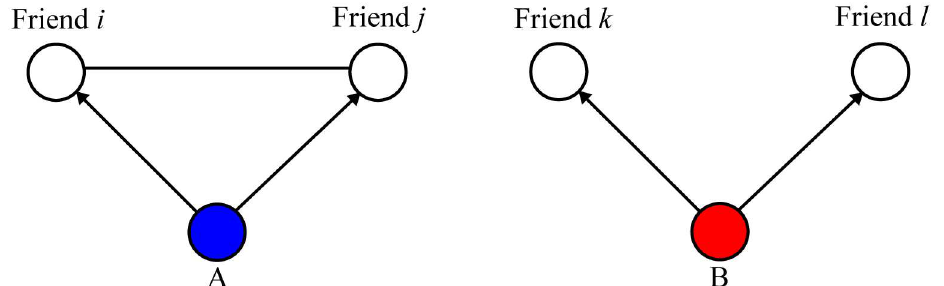
Fig 1. Types of social capital: An ego-network